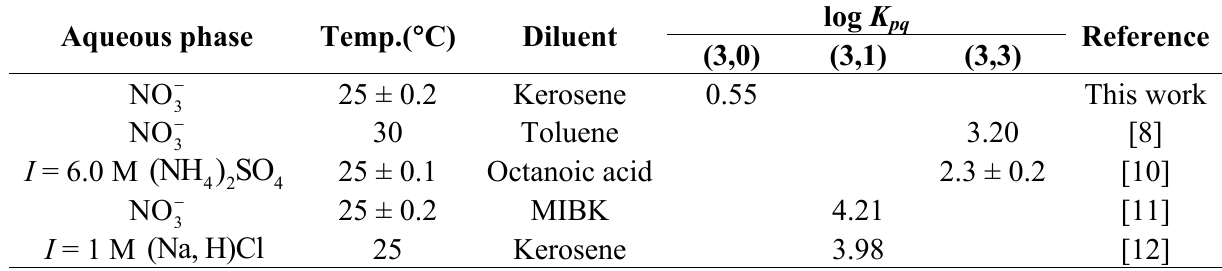
extracted by D2EHPA. p q